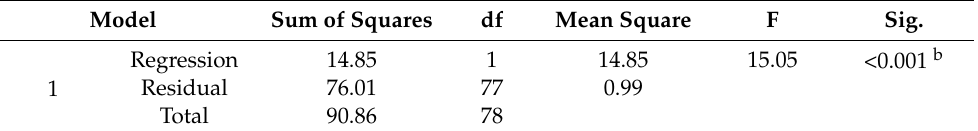
Table 7. ANOVA a .